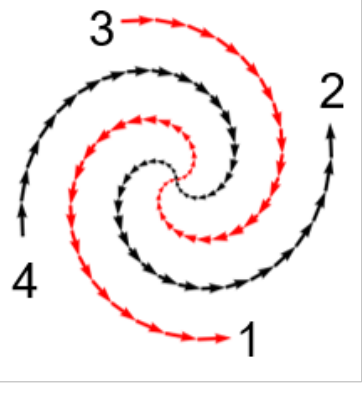
Figure A6. Print path of spiral in extrusion print system. Print path follows 3–1 and